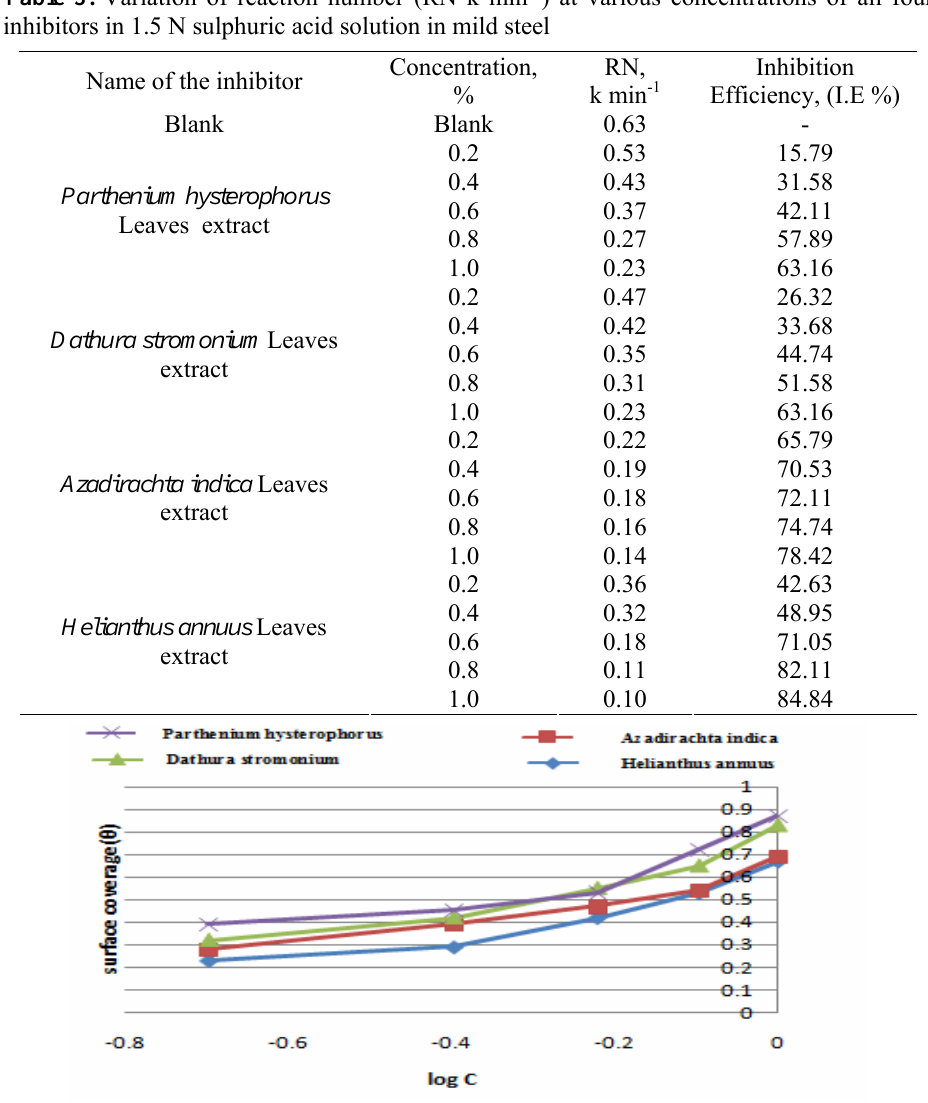
Figure 3 . Tempkin adsorption isotherm for the given